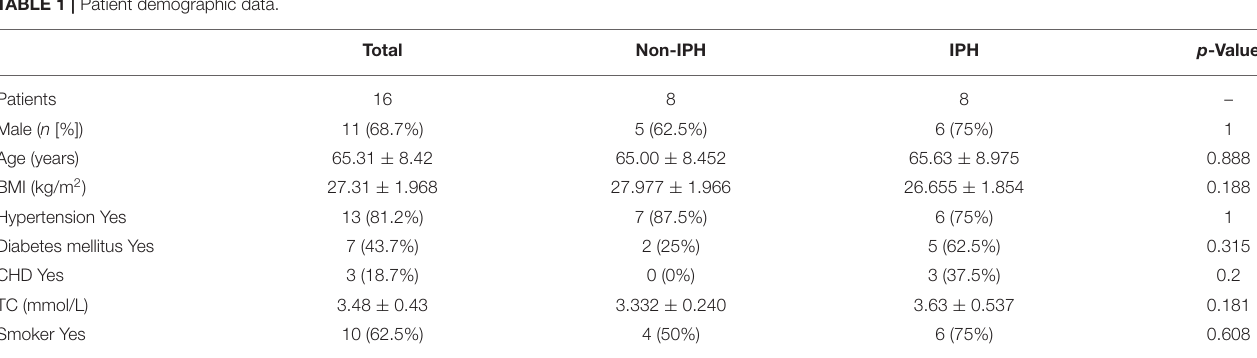
TABLE 1 | Patient demographic